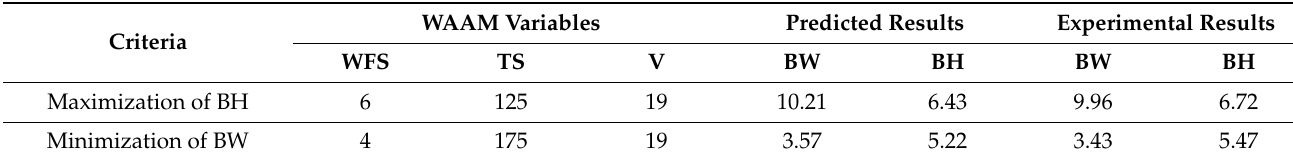
Table 6. HTS results for individual response geometries.